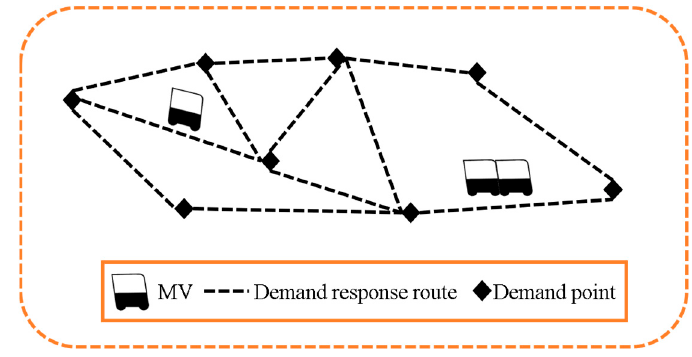
Figure 6. Demand response scenario.